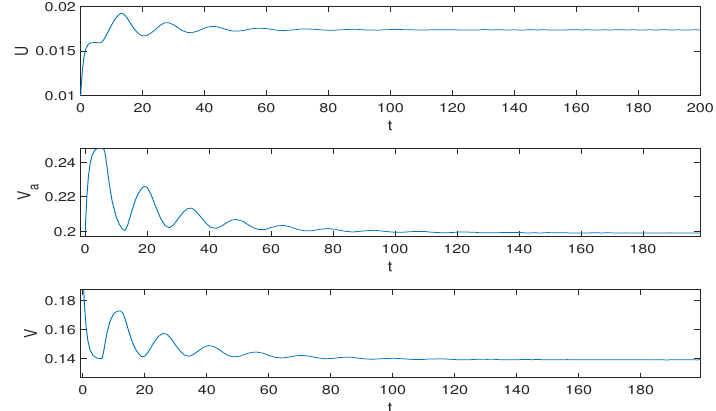
Figure 7. When τ = 6, the equilibrium P of system (1) is locally asymptotically stable. ( 0 ) = 35.2992, we choose the initial value ( 0.01, 0.2, 0.15 ) , the When τ = 35.5 > τ 1 model (1) has a stable forward periodic solution near the equilibrium P (see Figure 8).